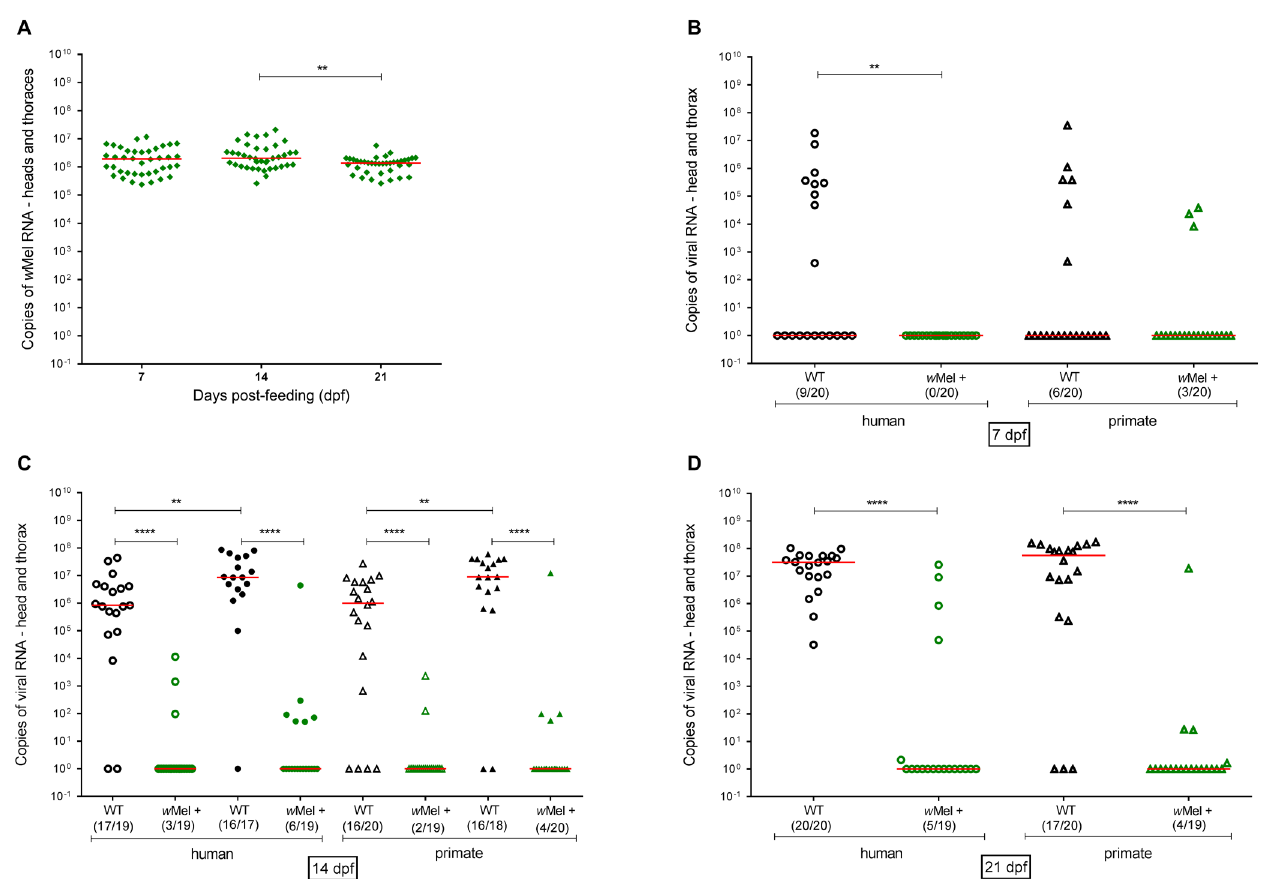
Figure 3. Interference of Wolbachia towards Yellow fever virus and Wolbachia absolute quantification. Wild type (WT) or positive ( w Mel +) were orally infected with two YFV isolates and virus dissemination in mosquitoes was analyzed at different times post infection. ( A ) YFV infected mosquitoes’ heads and thoraces were analyzed for Wolbachia density at different times post-infection through real time RT-qPCR, based on a Wolbachia standard curve. Red lines indicate the median w Mel copies (Mann-Whitney U test, ** p =0.0062). ( B ) Analysis of copies of viral RNA on 7dpf -WT x w Mel+ (** p =0.0028) and YFV Human x Primate WT ( p = 0.43), ( C ) 14dpf YFV Human and Primate WT x w Mel + (**** p <0.0001), YFV Human x Primate WT ( p =0.75), YFV Human x Primate extra blood meal WT ( p =0.78), YFV Human WT x WT extra blood meal (** p =0.0061) and YFV Primate WT x WT extra blood meal (** p = 0.0056) and ( D ) 21 dpf -WT x w Mel+ (**** p =0.0001) and YFV Human x Primate ( p = 0.51). Empty black circles and triangles are WT mosquitoes, whereas empty green circles and triangles depict mosquitoes with w Mel +. Black filled circles and triangles are mosquitoes that received a second blood meal. The red line indicates the median YFV